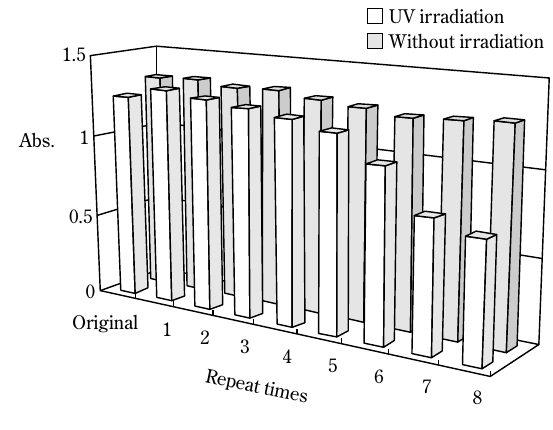
Fig. 6 Photocatalytic degradation and adsorption of MB in water using modified